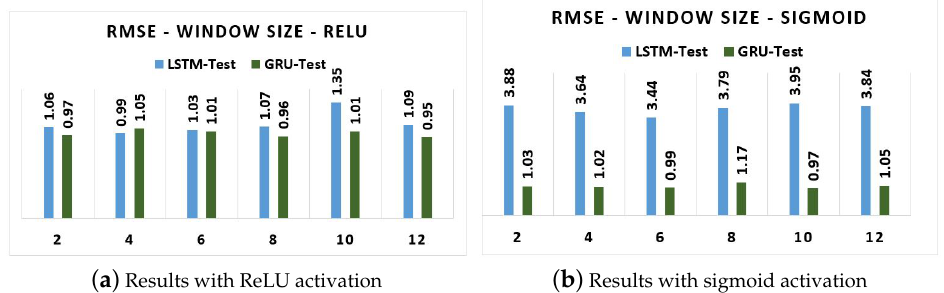
Figure 11. RMSE values for LSTM and GRU models, with different window sizes and activation functions for the output